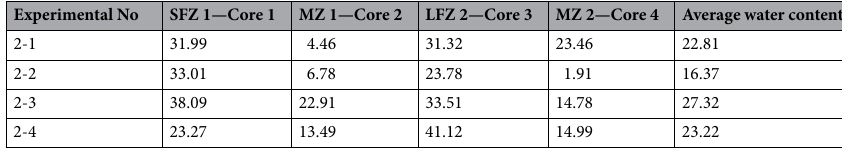
Table 7. Water saturation increment in different zones at the end of Group II (%).